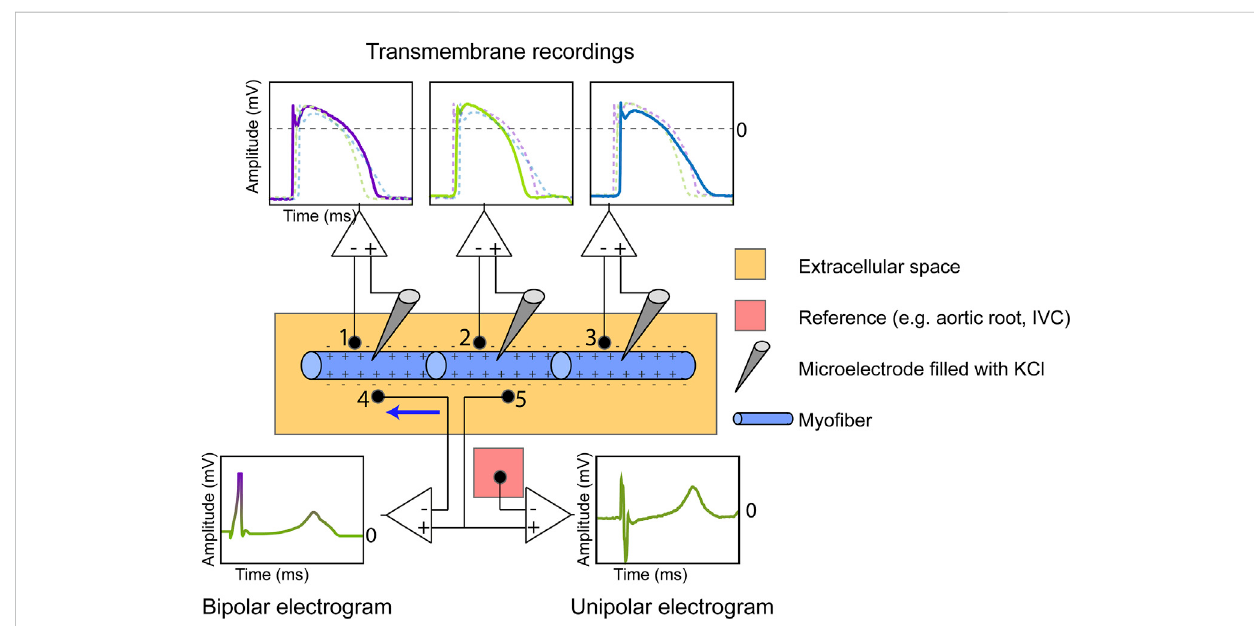
FIGURE 1 Measurement of the cardiac transmembrane action potential (TMP), bipolar electrogram and unipolar electrogram (UEG). The TMP is recorded by inserting an Ag/AgCl electrode fi lled with KCl in the intracellular space and using the extracellular potential as a reference. The number of myo fi bers is reduced for illustration purposes. The extracellular UEG is commonly referenced against electrically inactive tissue (e.g., aortic root, inferior vena cava (IVC)). The bipolar electrogram, measuring current in only one direction (from anode to cathode, see blue arrow), is equal to the subtraction of the UEG measured at location 4 from the UEG measured at location